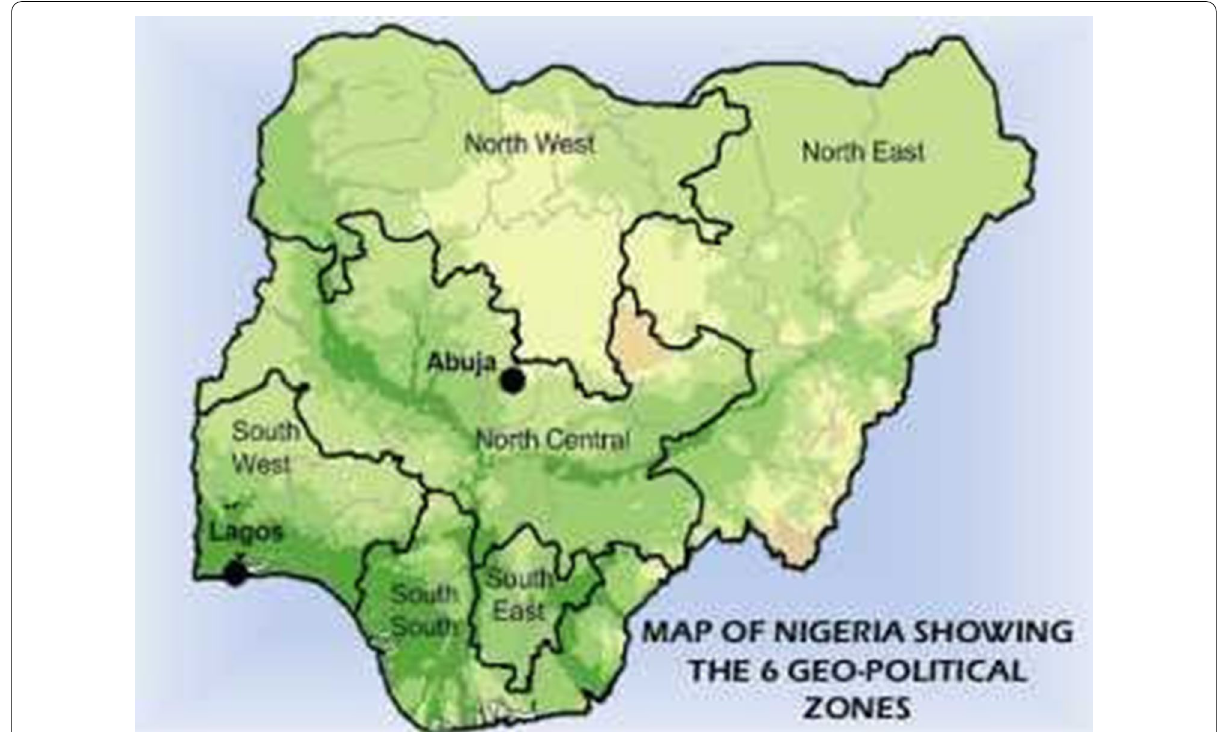
Fig. 1 Map of Nigeria showing the six geopolitical